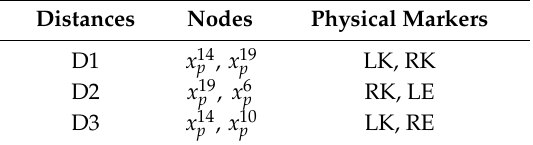
Table 1. Nodes and physical markers involved in evaluating distances D1, D2, and D3.